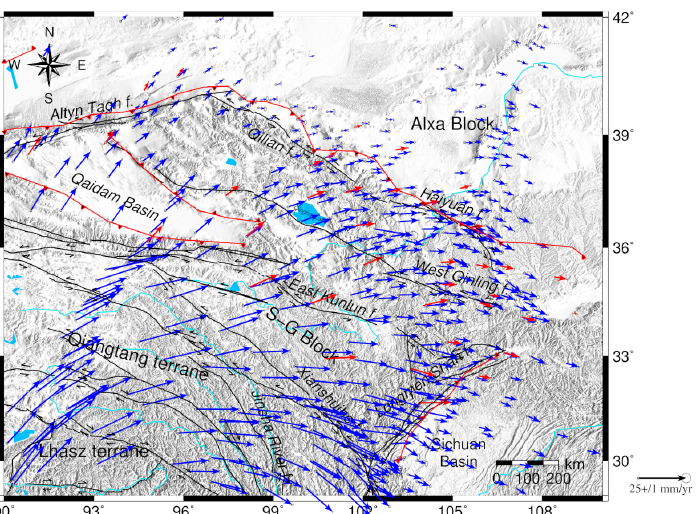
Figure 4. The velocity uncertainly of the GPS time series in three different directions, east, north, and up, over NET. Blue and red circles represent the GPS time series unfiltered CMEs and filtered GPS time series, respectively.